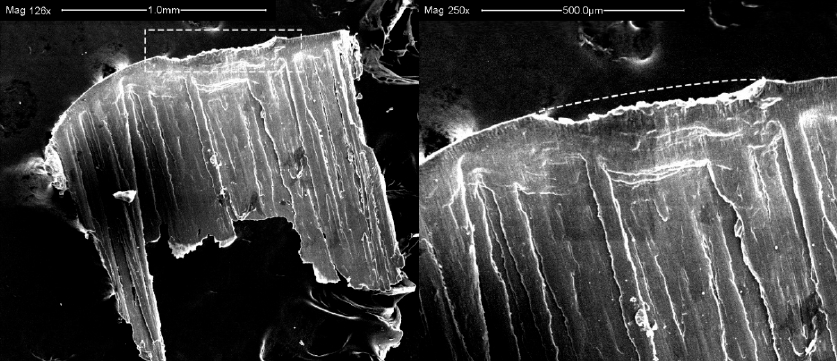
Figure 10. Scanning electron microscopy of the detached adhered material.